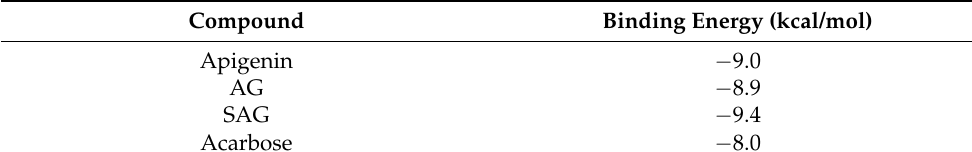
Table 2. α -glucosidase inhibitory activity and docking analysis of active compounds.